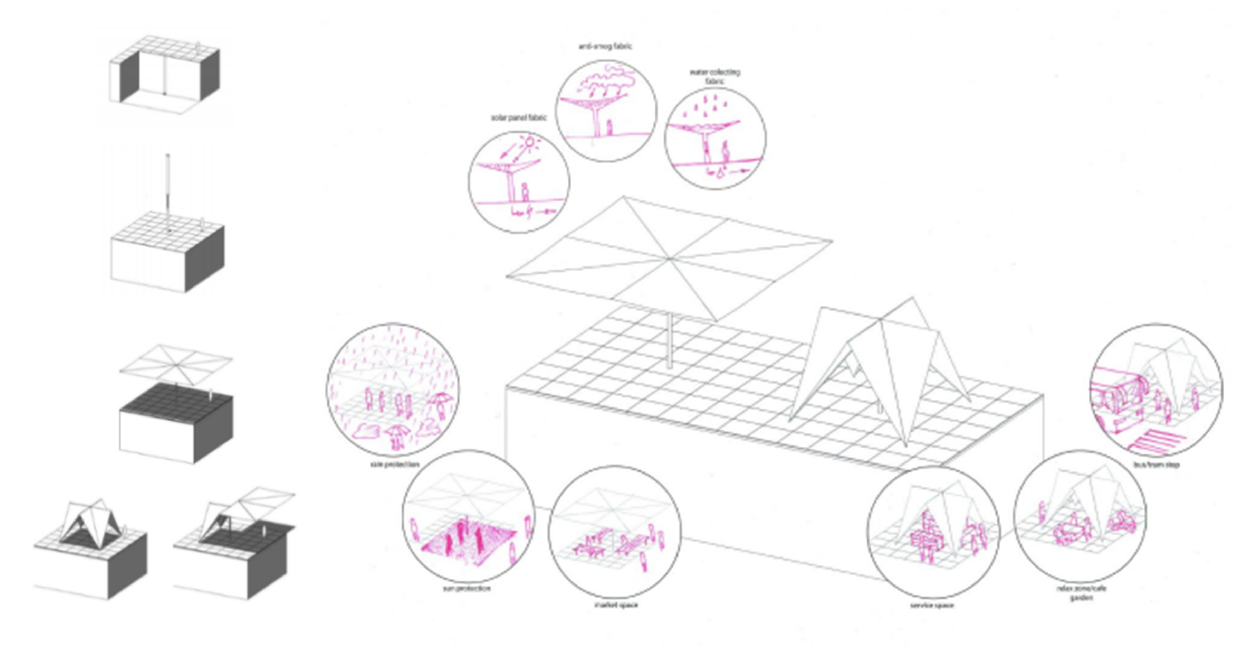
Figure 13. Visualizations and diagrams presenting the functions that a single umbrella can perform and their combination on a city square.